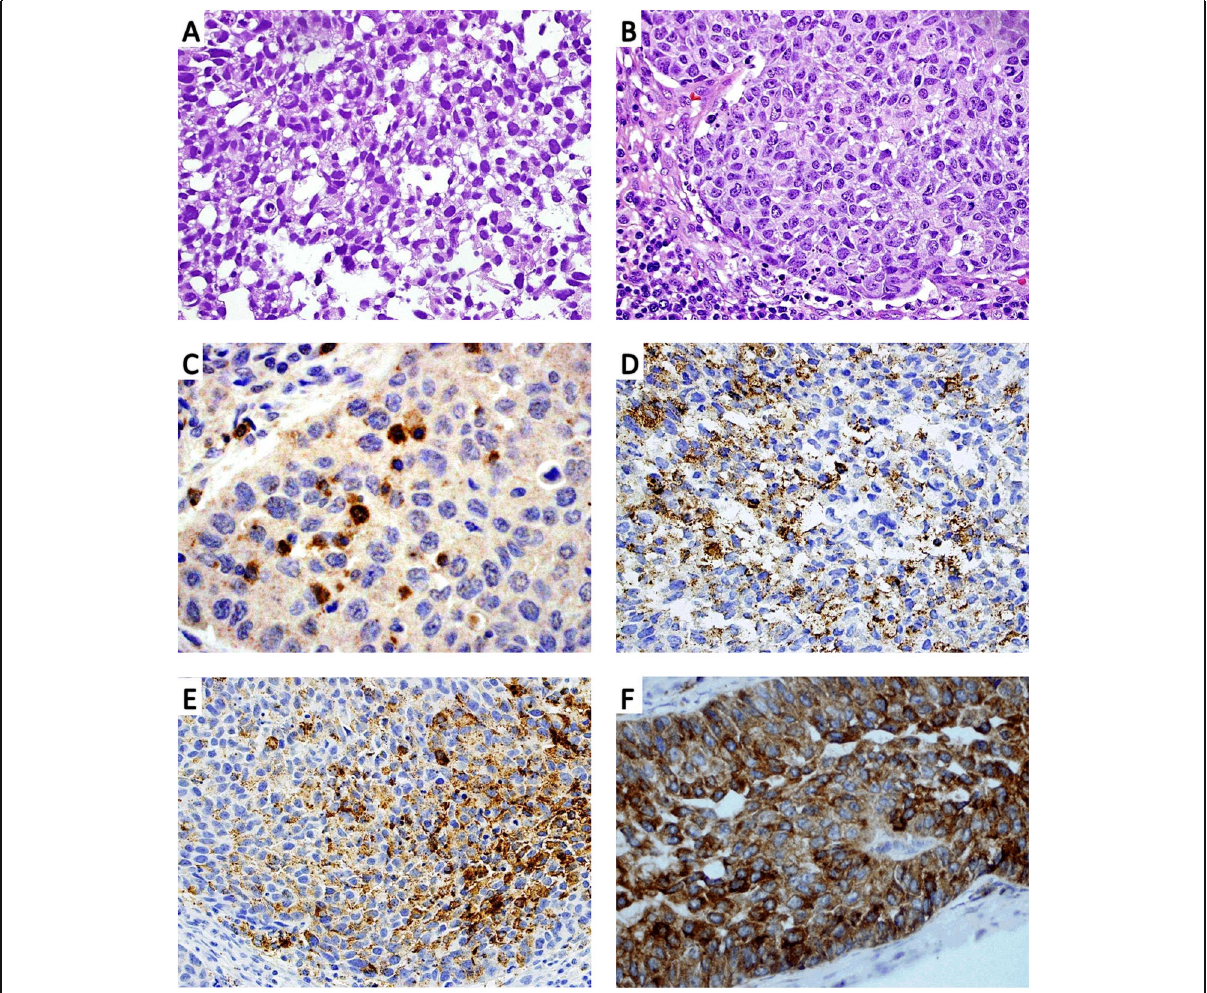
Fig. 1 Muscle invasive urothelial carcinoma. a Diffuse sheet of neoplastic cells with pleomorphic hyperchromatic nuclei, inconspicuous nucleoli and pale eiosinophilic cytoplasm (H&E, 20x); b Diffuse sheet and nest of neoplastic cells with pleomorphic vesicular nuclei, coarse nuclear chromatin, prominent nucleoli, abundant eiosinophilic cytoplasm and apoptotic debri (H&E, 20x); c : Focal (1+) and strong cytoplasmic granular LHRHR staining in tumor cells (LHRHR immunostain, 40x); d: Focal (2+) and strong cytoplasmic granular LHRHR staining in urothelial carcinoma cells (LHRHR immunostain, 20x); e: Strong membranous and granular cytoplasmic LHRHR immunostaining (3+) in urothelial carcinoma cells (LHRHR immunostain, 20x); f : Strong membranous and cytoplasmic immunostaining for LHRHR (4+) in urothelial carcinoma cells (LHRHR immunostain,